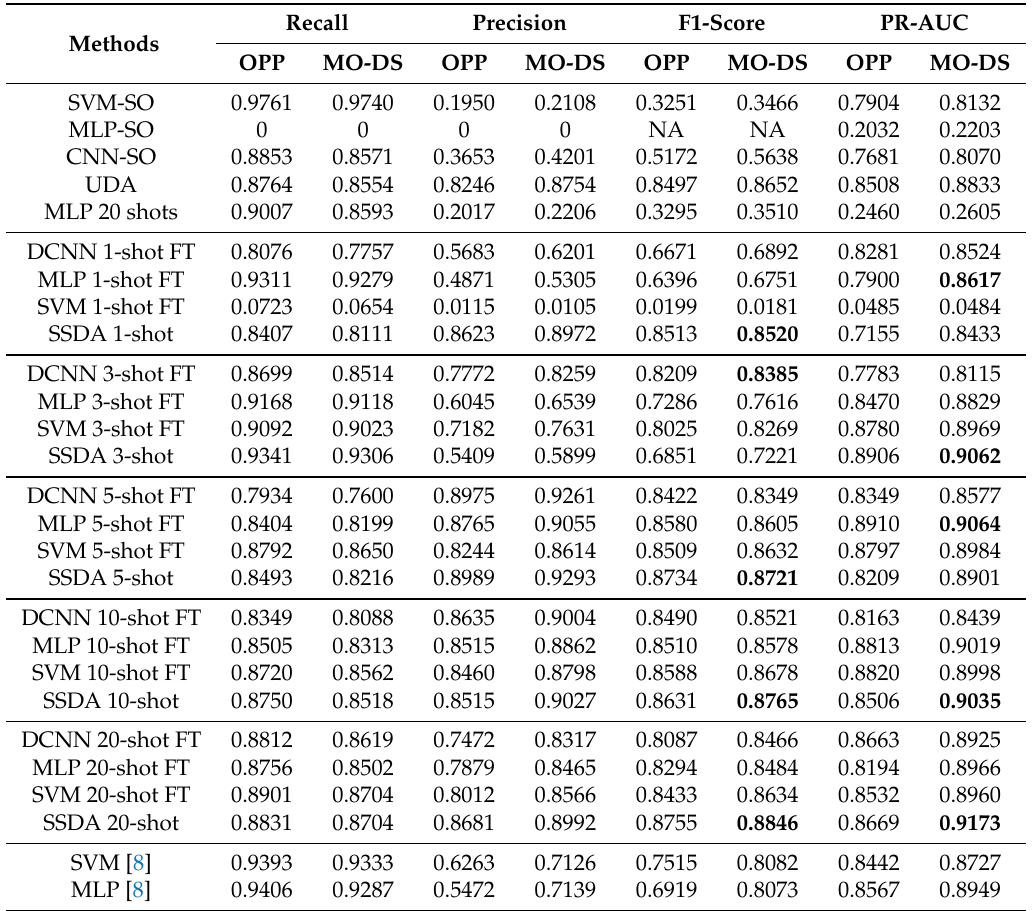
Table 1. Performance comparison. Precision, Recall, and F-1 score are calculated using 0.5 as threshold, and the area under the PR curve (AUC) values are computed on the OPP and MO-DS images. OPP: Original predication probability. MO-DS: Morphological operation with a disk